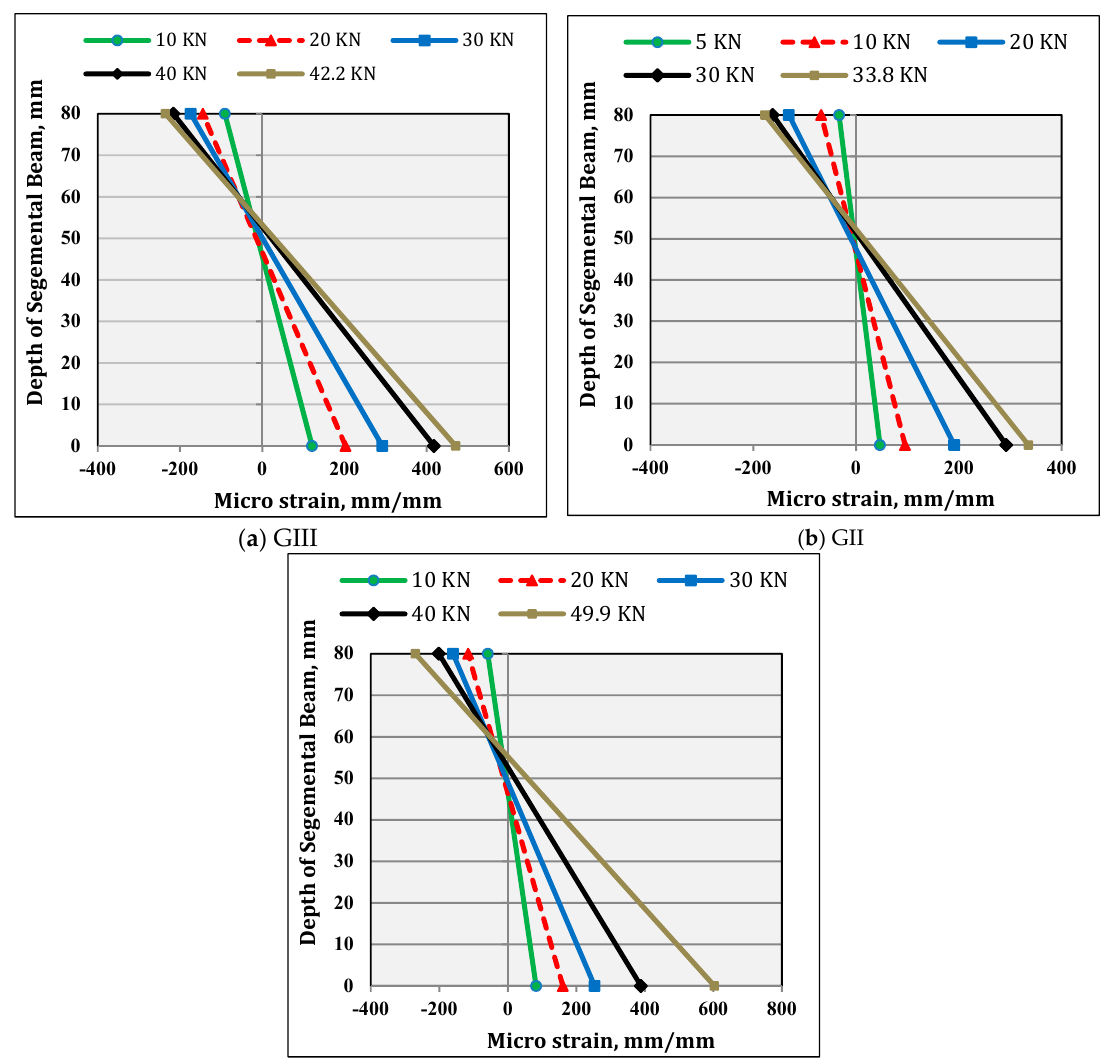
Figure 15. Strain gradient across the depth for an average of each group of segmental beams.